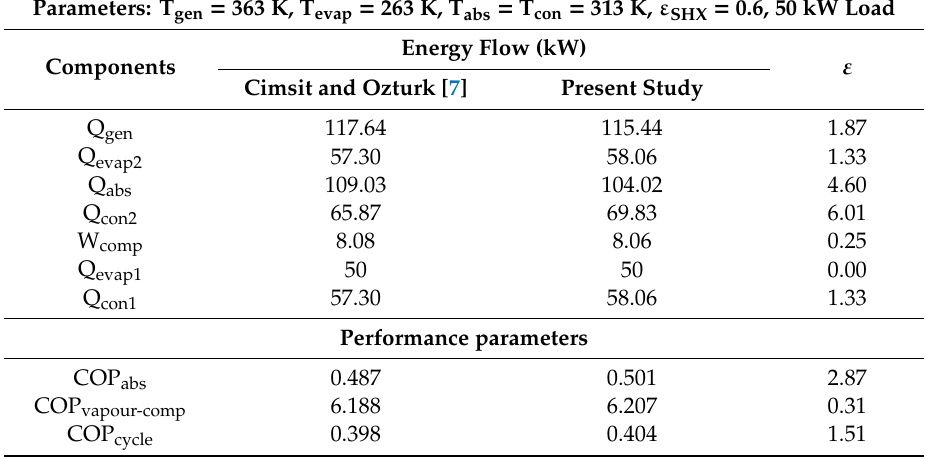
Table 2. Comparison of present model with model by Cimsit and Ozturk [7].